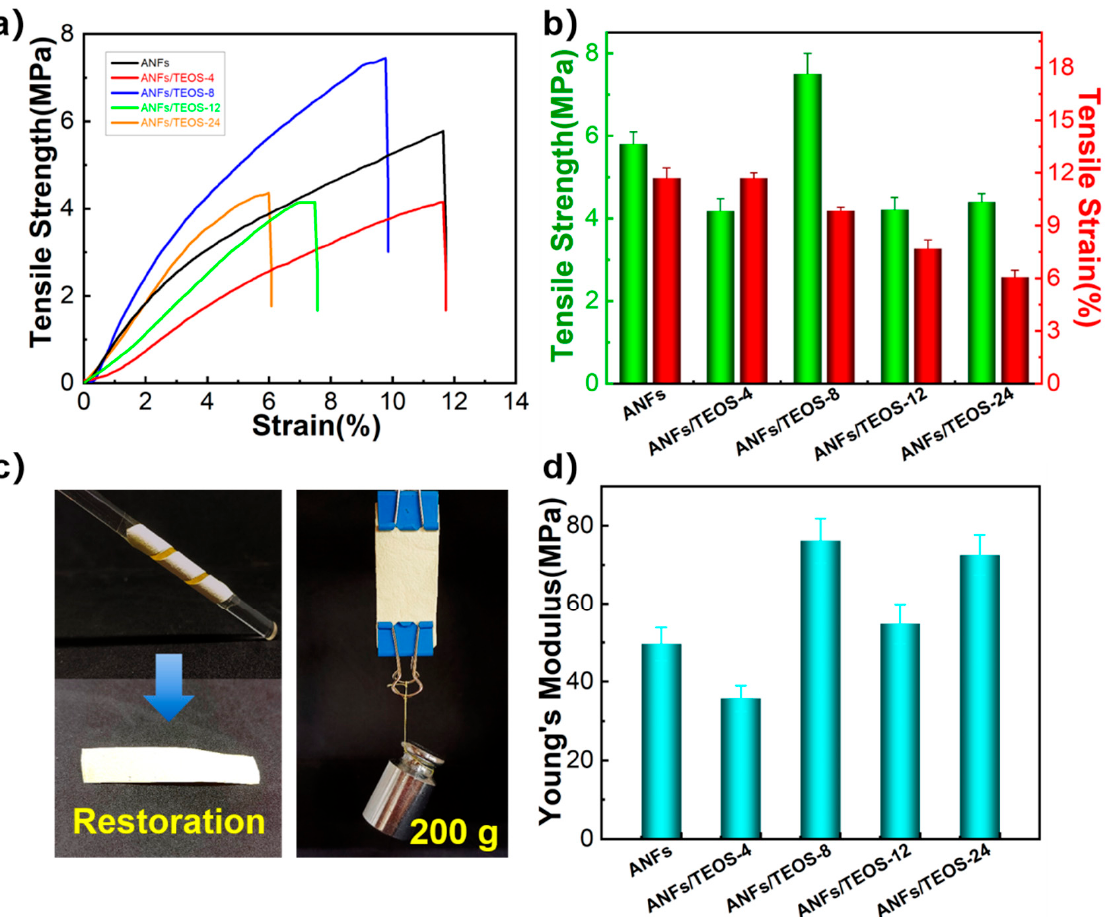
Figure 5. Mechanical performance of aerogels. ( a ) Stress–strain curves, ( b ) Tensile strength and elon- gation at break, ( d ) Young’s modulus of ANFs aerogel and aramid fibers@silica aerogels obtained by different CVD times. ( c ) Flexibility and mechanical strength demonstration of ANFs/TEOS-8.